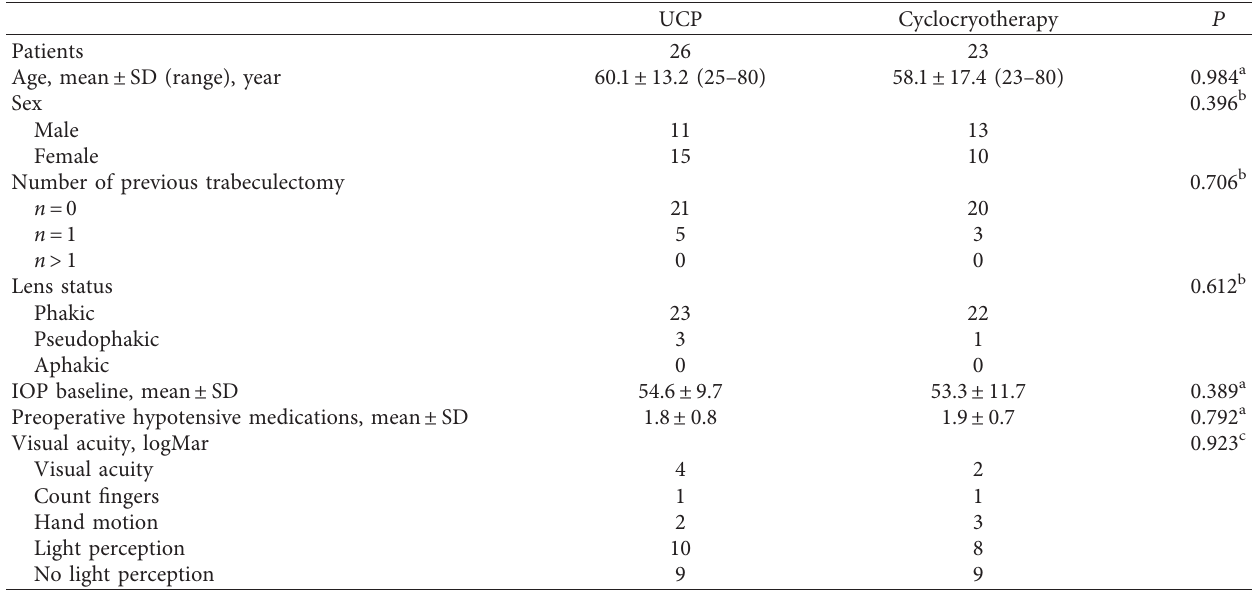
Table 1: Patients